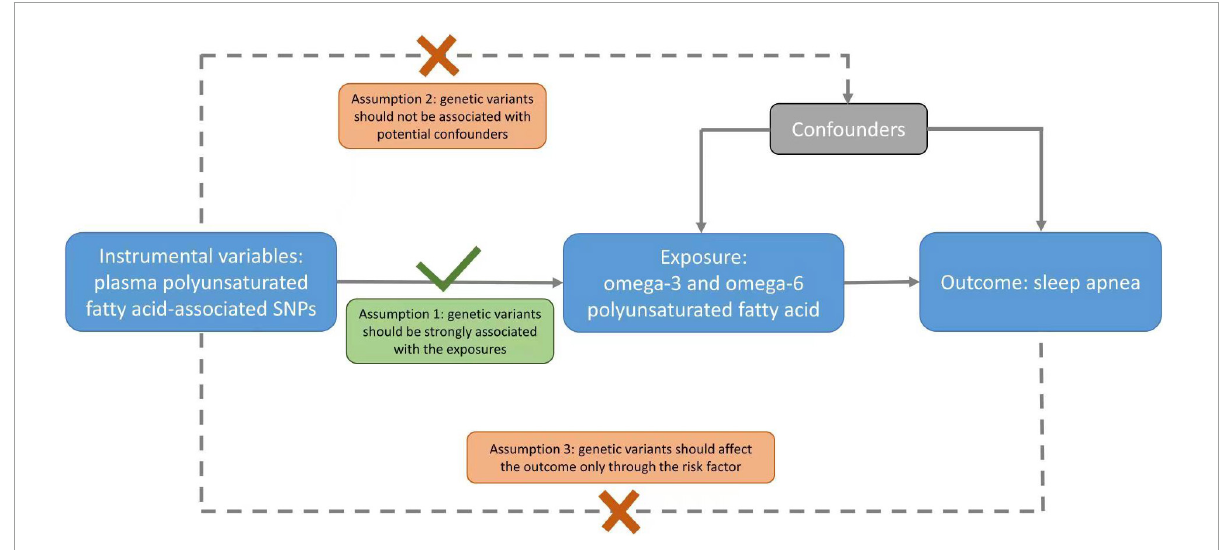
FIGURE1 A schematic diagram of the Mendelian randomization (MR) assumptions underpinning an MR analysis of the association of plasma fatty acid levels with sleep apnea (SA). The dashed lines represent the possible violations of the MR